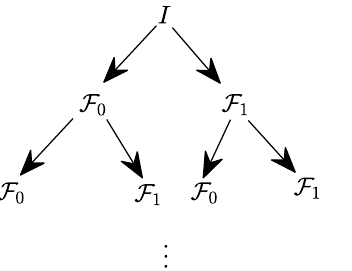
Figure 2. The binary tree structure of the Function Systems F (cid:101) .